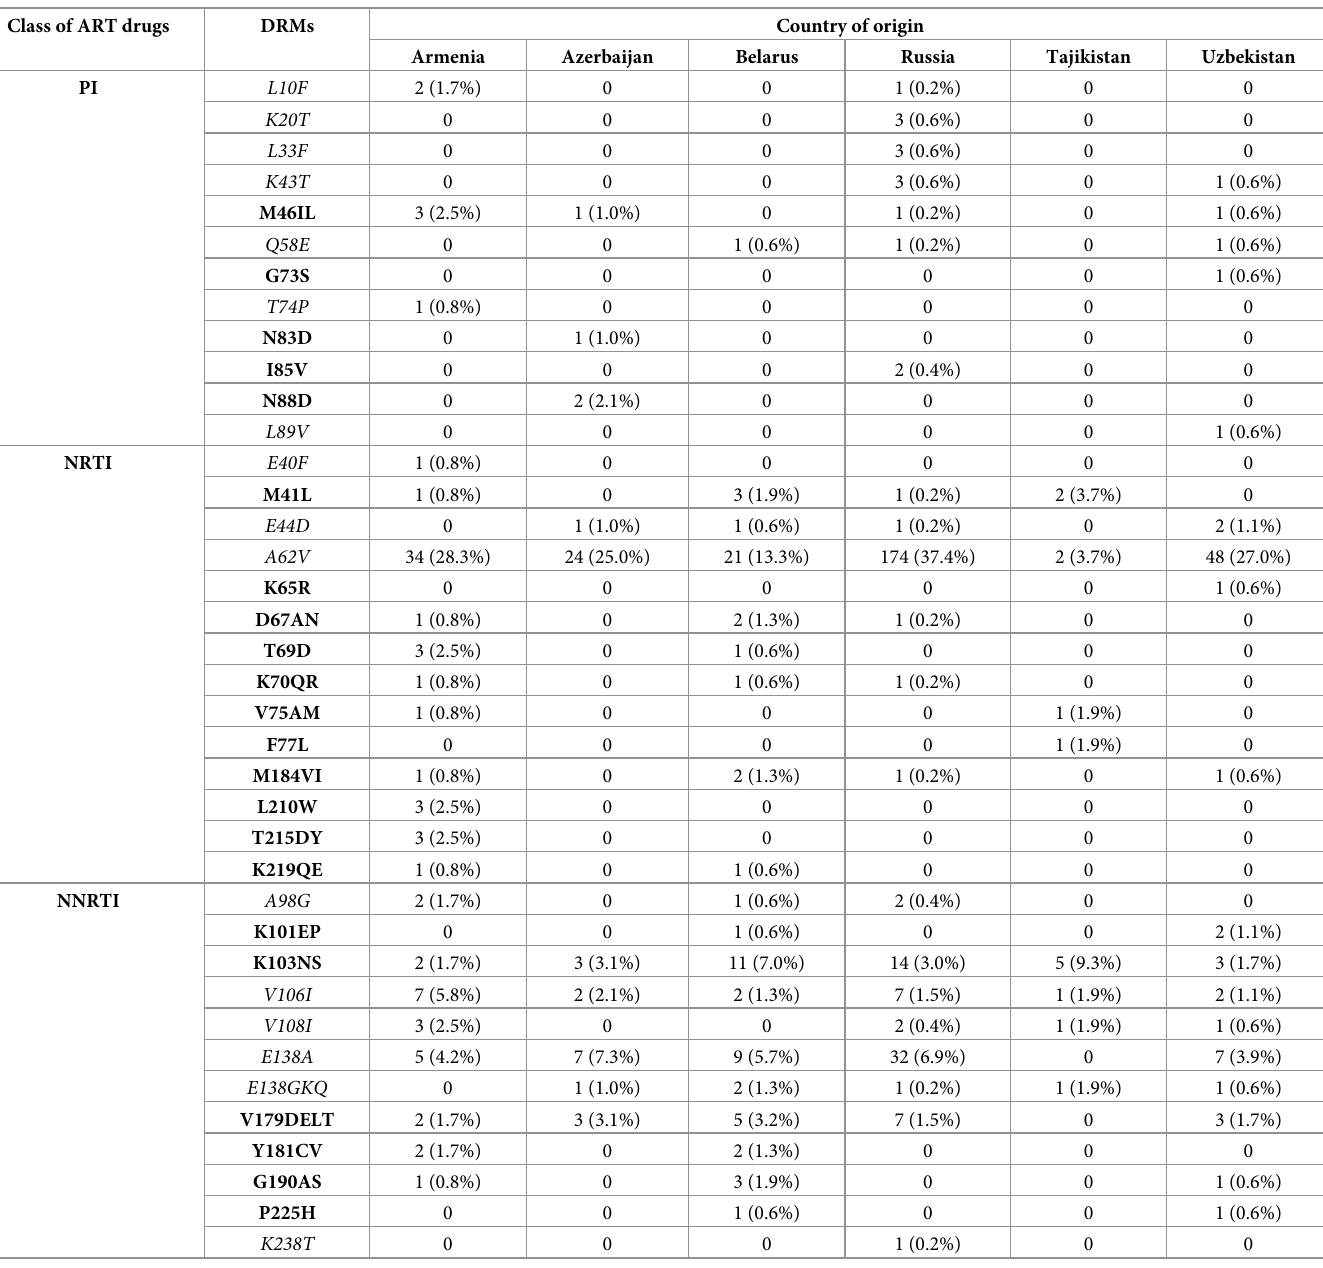
Table 4. Prevalence of drug resistance mutations. Class of ART